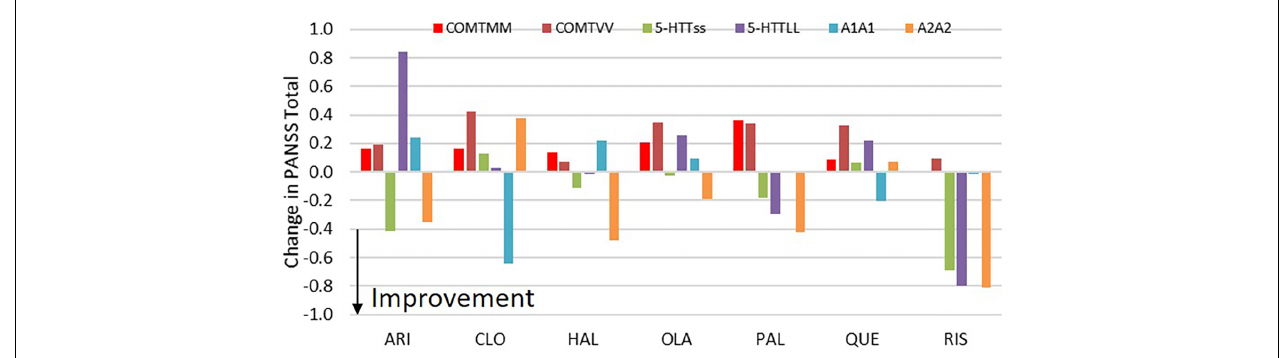
FIGURE 1 | Effect of COMT, 5-HTTLPR rs25531 and D2DRTaq1 genotypes on change in PANSS total vs. placebo for the different antipsychotics at their standard doses. The figure shows the differential effects of the homozygotes (for instance MM/*/* and VV/*/*) vs. the heterozygote subjects (for instance MV/*/*). All results are averaged over the 9 possible combinations of the other two genotypes with the appropriate distribution depending upon the frequency of the genotypes. The biggest effects for the most drugs are seen with the DRD2Taq1 allele, where the */*/A2A2 genotype tends to increase clinical response for drugs with strong D 2 R antagonism, but with an opposite effect for drugs with weak D 2 R antagonism (clozapine and quetiapine). The effect of COMT genotype is limited, but the 5-HTT LPR genotype only has an effect with aripiprazole (*/LL/* worsens outcome) and a complex relationship with risperidone where */Ls/* has the worst outcome.